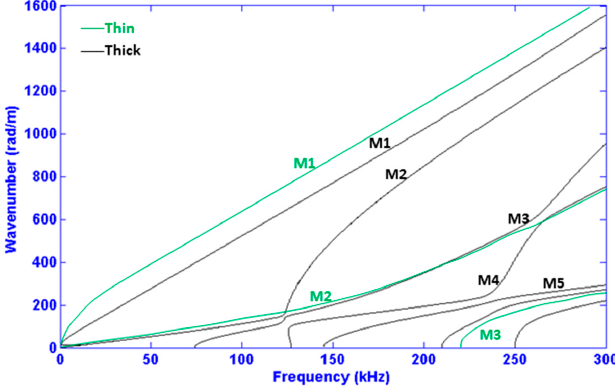
Figure 1. Dispersion curves in two cases of COPV thicknesses: thin (black) and thick multi-layer (green) with a thickness equal two times that of the thinner one (5 mm). M i is the i th mode where i represents its order.